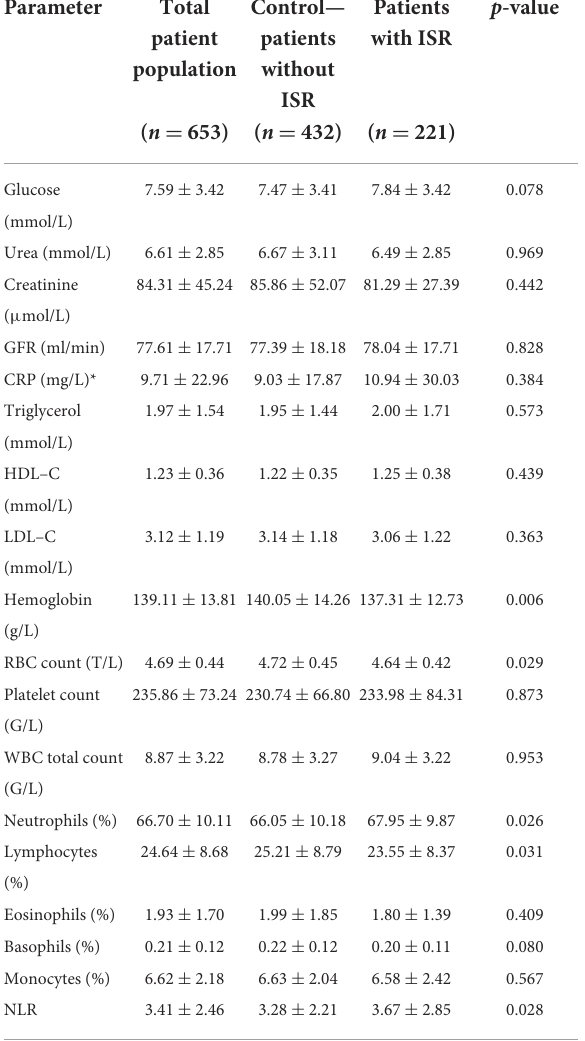
TABLE 3 Baseline blood chemistry and blood count results.